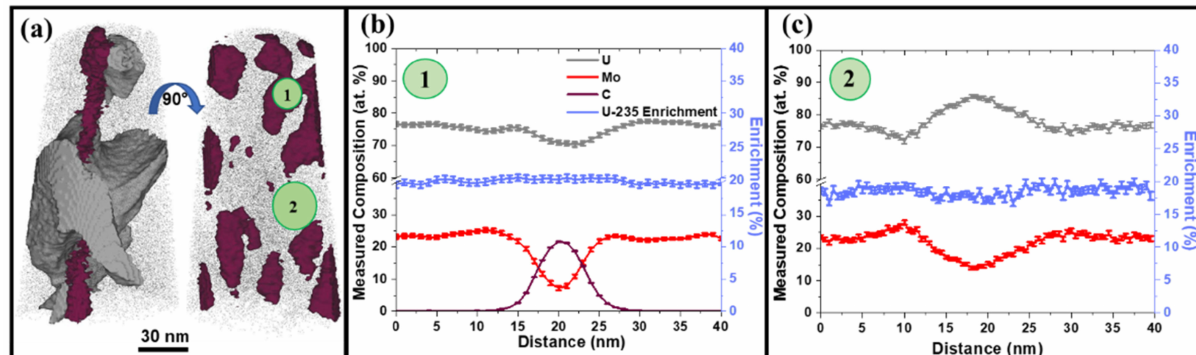
Figure 5. ( a ) 3D distribution of U-C shown with iso-concentration surfaces of C (shown in brown) and α -U (shown in grey) along the grain boundary, and 90 ◦ rotated view of analyzed volume shown in ( a ) showing platelet-shaped carbides along the grain boundary. ( b , c ) 1D profile taken across the grain boundary by placing a cylinder along carbide precipitates and without precipitate, respectively. (brown: C, blue: enrichment, grey: U, red: